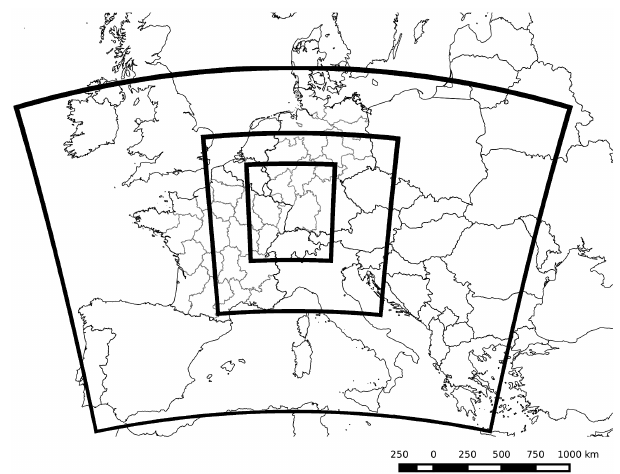
Figure 2. WRF model set up with a parent domain of resolution 27km × 27km and two nests of 9km × 9km and 3km × 3km, re-